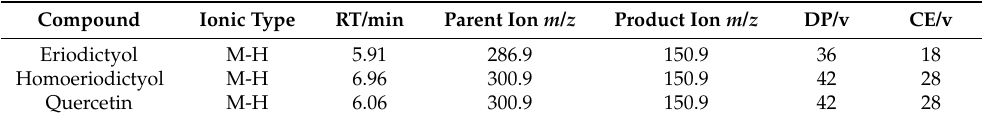
Table 2. Optimized mass spectrometry conditions parameters for three compounds, retention time (RT), declusterin pressure (DP), collision energy